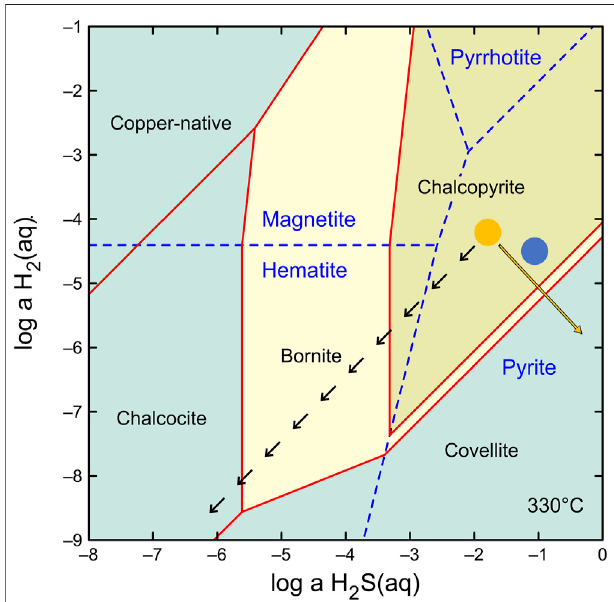
FIGURE 10| Mineral stabilities in the Cu-Fe-S-O-H system for variable a (H 2 ) and a (H 2 S) at 330 ° C and 250 bar. The composition of fl uids from Maka South (orange circle) and Maka HF (blue circle) were depicted assuming unit activity coef fi cients for H 2 and H 2 S. The orange arrow points in the direction ofincreasingsulfurfugacity (i.e., high sulphidation). Theblack arrows represent the suggested sequence of chalcopyrite followed by bornite and chalcocite as H 2 and H 2 S decrease towards the outer chimney wall. The orangearrowsrepresentthesuggestedreplacementreactionsofchalcopyrite – bornite followed by bornite – chalcocite at Maka